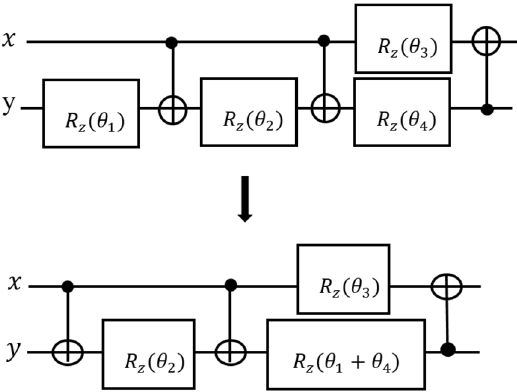
Figure 2. Integration of two rotation gates 16 .